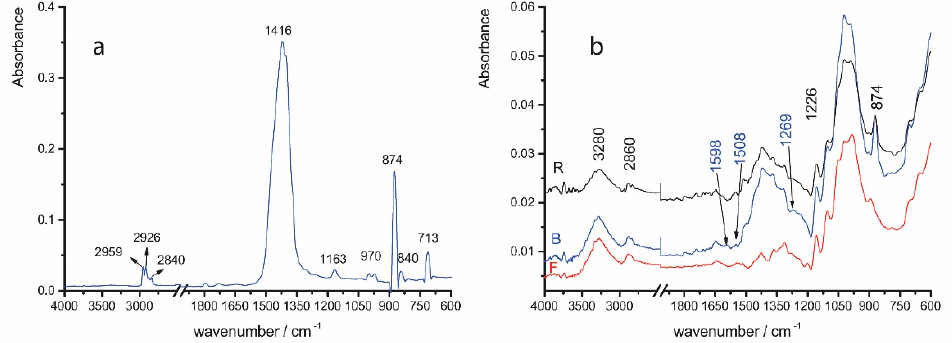
Figure 3. FTIR spectra of ( a ) synthetic paper and ( b ) recycled (R), bulky (B), and filter (F) papers.